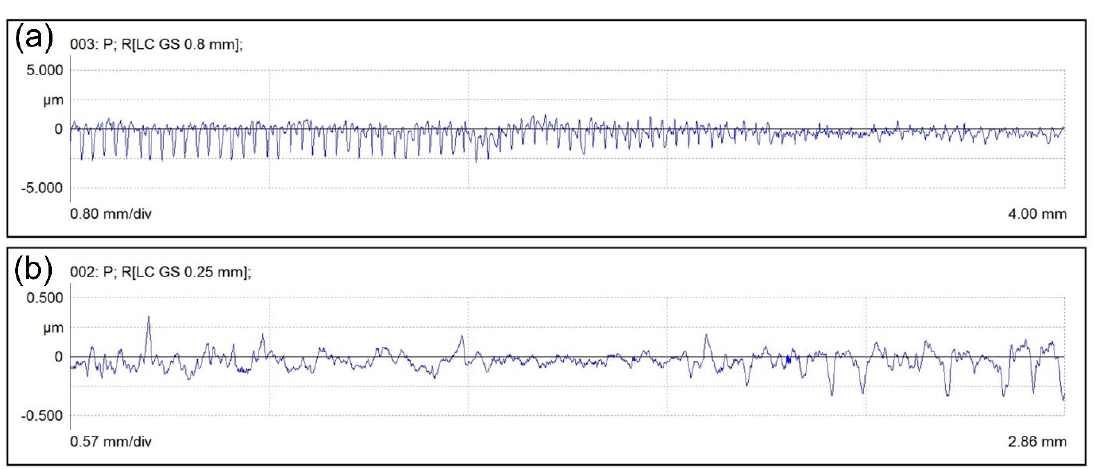
Figure 3. Surface profiles of ( a ) turned and ( b ) electropolished specimens. Table 1. Values of several surface roughness parameters of the turned and the electropolished specimens.